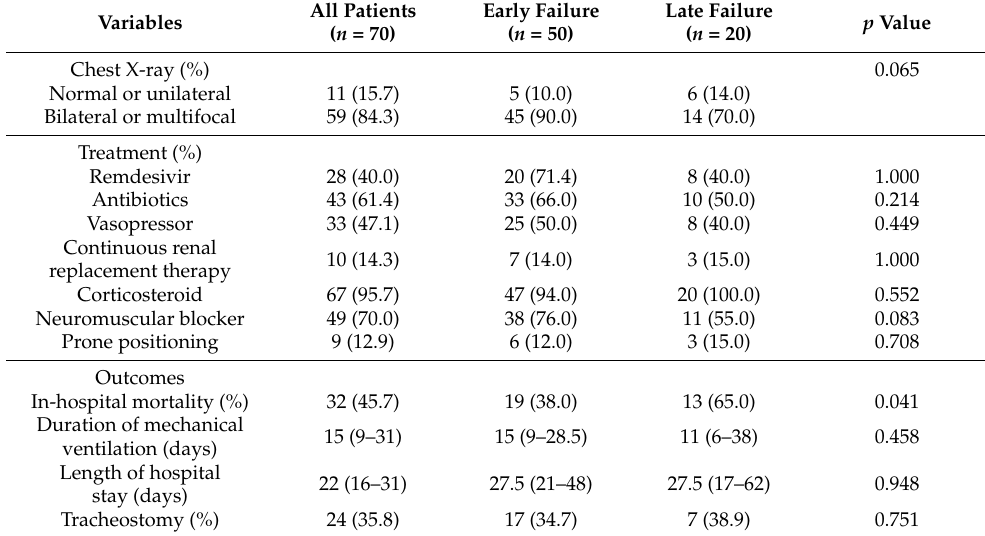
( b ) Figure 3. Comparison of ROX index and SpO 2 /FiO 2 ratio before 2 h of intubation ( a ) ROX index, 5.74 (IQR: 4.58–6.98) in early failure group and 4.80 (IQR: 3.67–5.97) in late failure group, respectively ( p = 0.040). ( b ) SpO 2 /FiO 2 ratio, 125 (103– 161) in early failure group and 116 (102–130) in late failure group, respectively ( p = 0.134). ROX=pulse oximetry/fraction of inspired oxygen/respiratory rate; FiO 2 = fraction of inspired oxygen; and SpO 2 = percutaneous oxygen saturation. 3.3. Predictive Factors of Mortality in Mechanically Ventilated COVID-19 Patients The results of the univariate and multivariable logistic regression analyses for in- hospital mortality are shown in Table 2. In the univariate analysis, age ≥ 70 years (odds ratio [OR], 5.353 [95% CI: 1.793–15.985], p = 0.003), CCI ≥ 3 (OR, 6.304 [95% CI: 1.626– 24.441], p = 0.008), SOFA score ≥ 3 (OR, 3.514 [95% CI: 1.287–9.593)], p = 0.014), neuromus- cular blocker use (OR, 0.290 [95% CI: 0.099–0.853], p = 0.024), and late HFNC failure (OR, 3.030 [95% CI: 1.027–8.939], p = 0.045) were associated with mortality. Table 2. Univariate and multivariate analyses of predictive factors for mortality. Variables